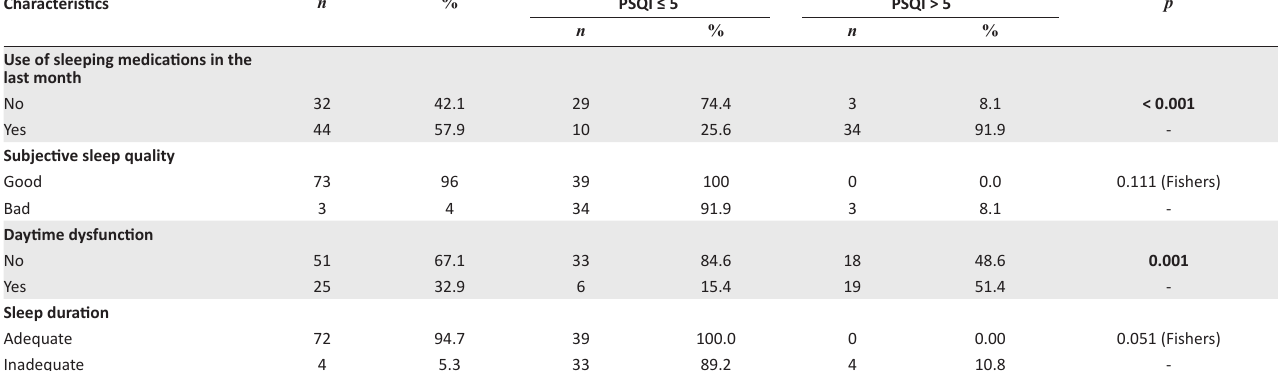
TABLE 2b: Characteristics of sleep quality in bipolar